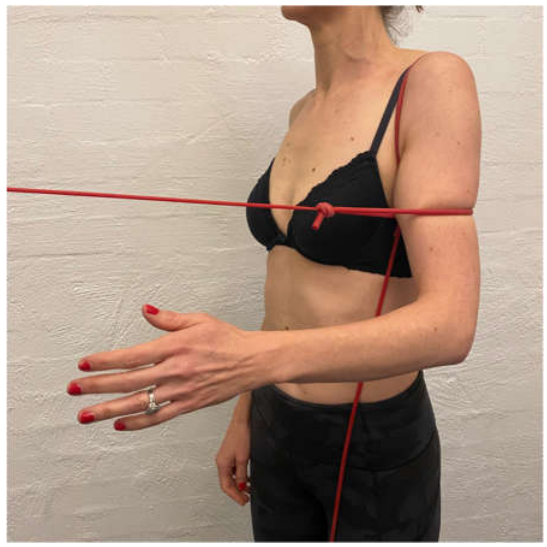
Figure 6. Humeral head band.